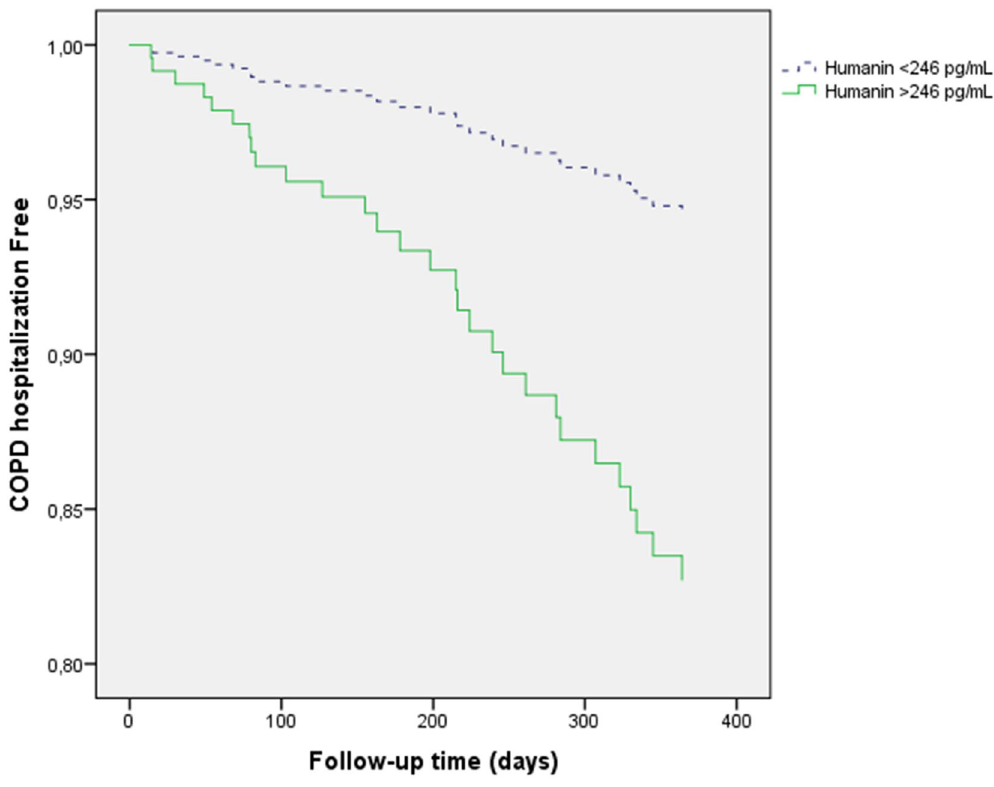
Figure 3. High serum humanin levels (higher than the median) as predictors of severe COPD exacerbations.